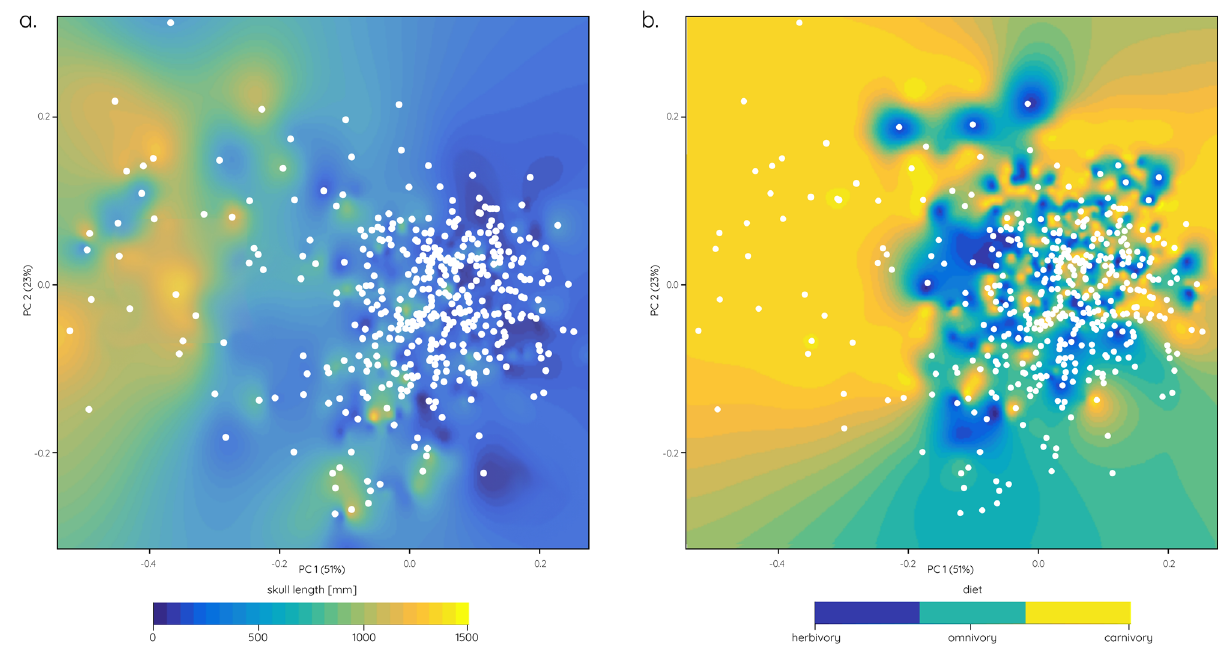
Fig. 5 In fl uence of skull size and diet on orbital shape. a Skull length heatmap superimposed on orbital shape morphospace (as in Fig. 1). b Dietary regimes heatmap superimposed on orbital shape morphospace (as in Fig.